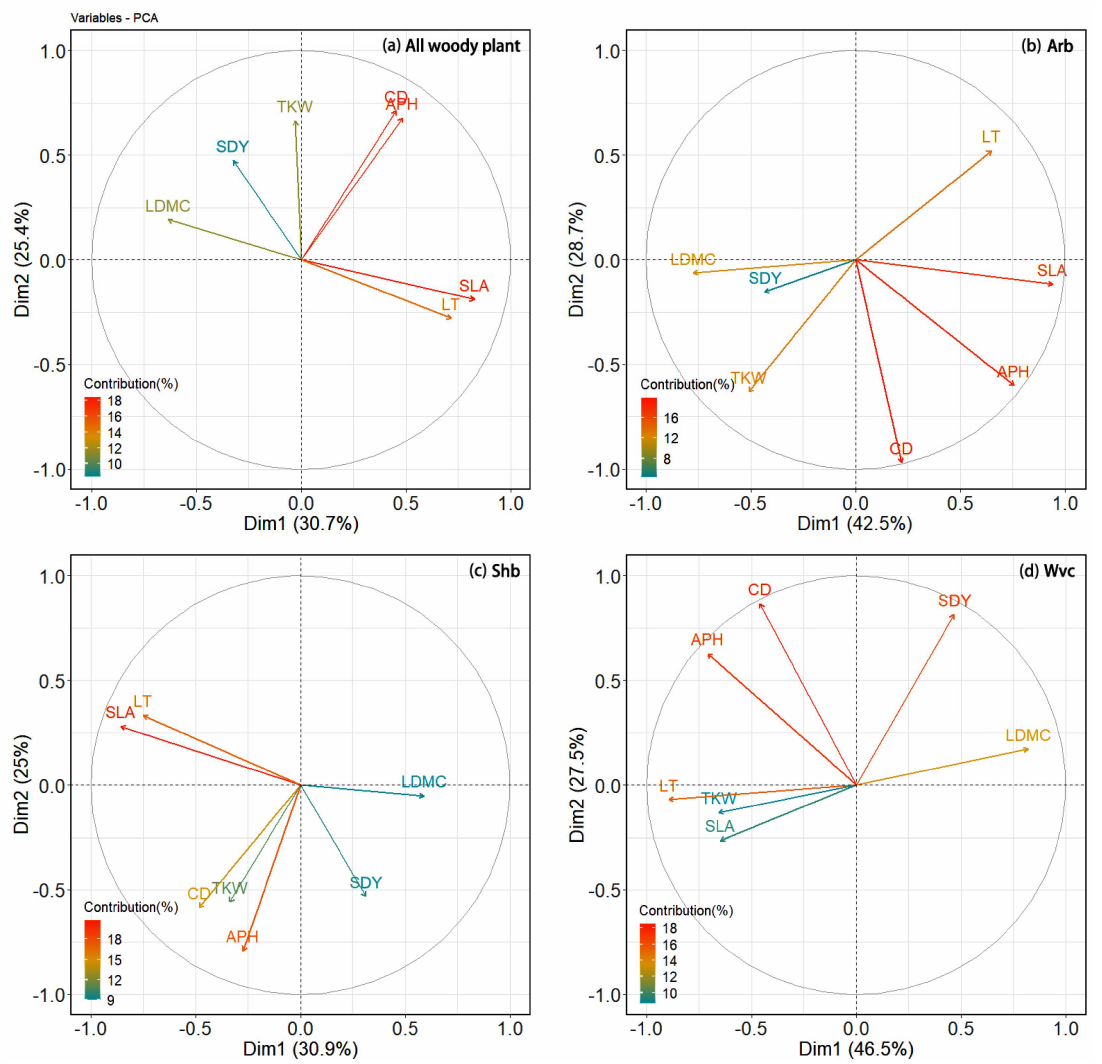
Figure 4. Principal component analyses of woody plant functional traits across WFTs. Abbreviations are as follows: Arb, arbors; Shb: shrubs and small arbors; Wvc, woody vines and climbing shrubs; SLA, specific leaf area; LDMC, leaf dry matter content; SDY, stem density; LT, leaf thickness; APH, average plant height; CD, crown diameter; TKW, thousand kernel